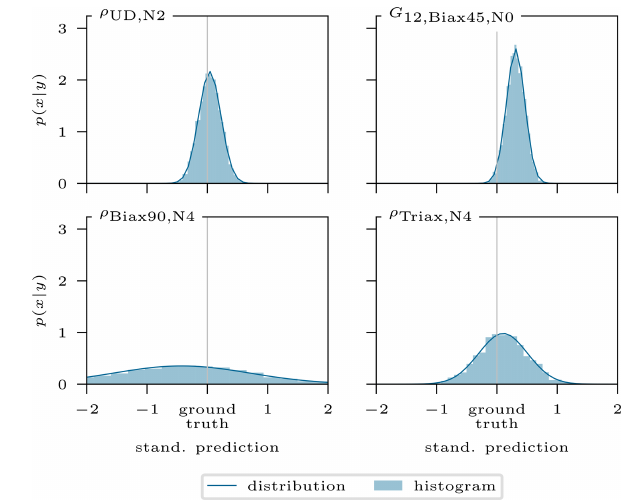
Figure 7. Conditional invertible neural network’s standardized pos- terior prediction distributions p ( x | y ) for four input features of one example. Plotted as a histogram and fitted Gaussian